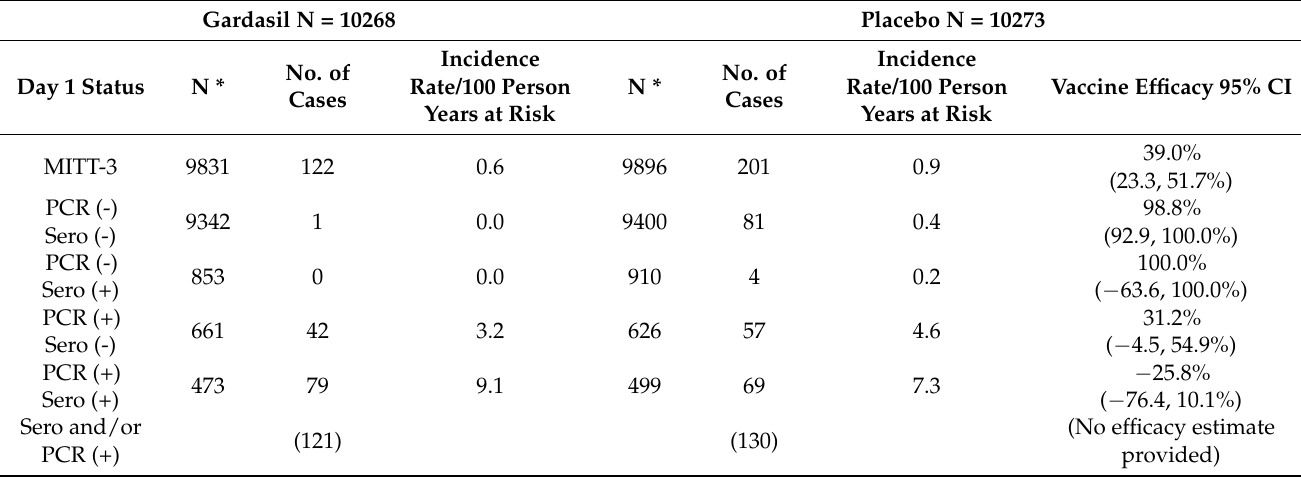
Table 2. Protocols 005, 007, 013, and 015: efficacy against HPV 16/18-related CIN 2/3, AIS or worse—MITT-3 population, by initial baseline HPV